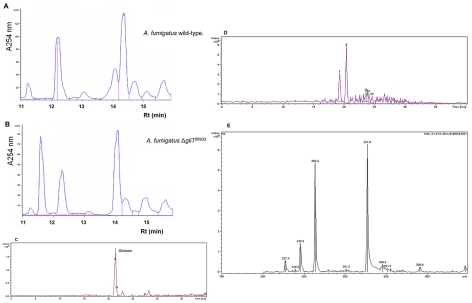
Gliotoxin is not produced by A. fumigatus ΔgliT.(A) HPLC chromatogram of an organic extract from A. fumigatus ATCC26933 indicating gliotoxin presence with Rt = 14.5 min. (B) HPLC chromatogram of organic extracts from A. fumigatus ΔgliT
26933 indicating gliotoxin absence but a new metabolite with Rt = 11.7 min. (C) LC-MS analysis of an organic extract from A. fumigatus ATCC26933 indicating gliotoxin presence. (D) LC-MS analysis of A. fumigatus ΔgliT
26933 confirms absence of secreted gliotoxin. (E) MS2 of gliotoxin present in wild-type A. fumigatus indicating expected sub-fragments as noted previously [10].